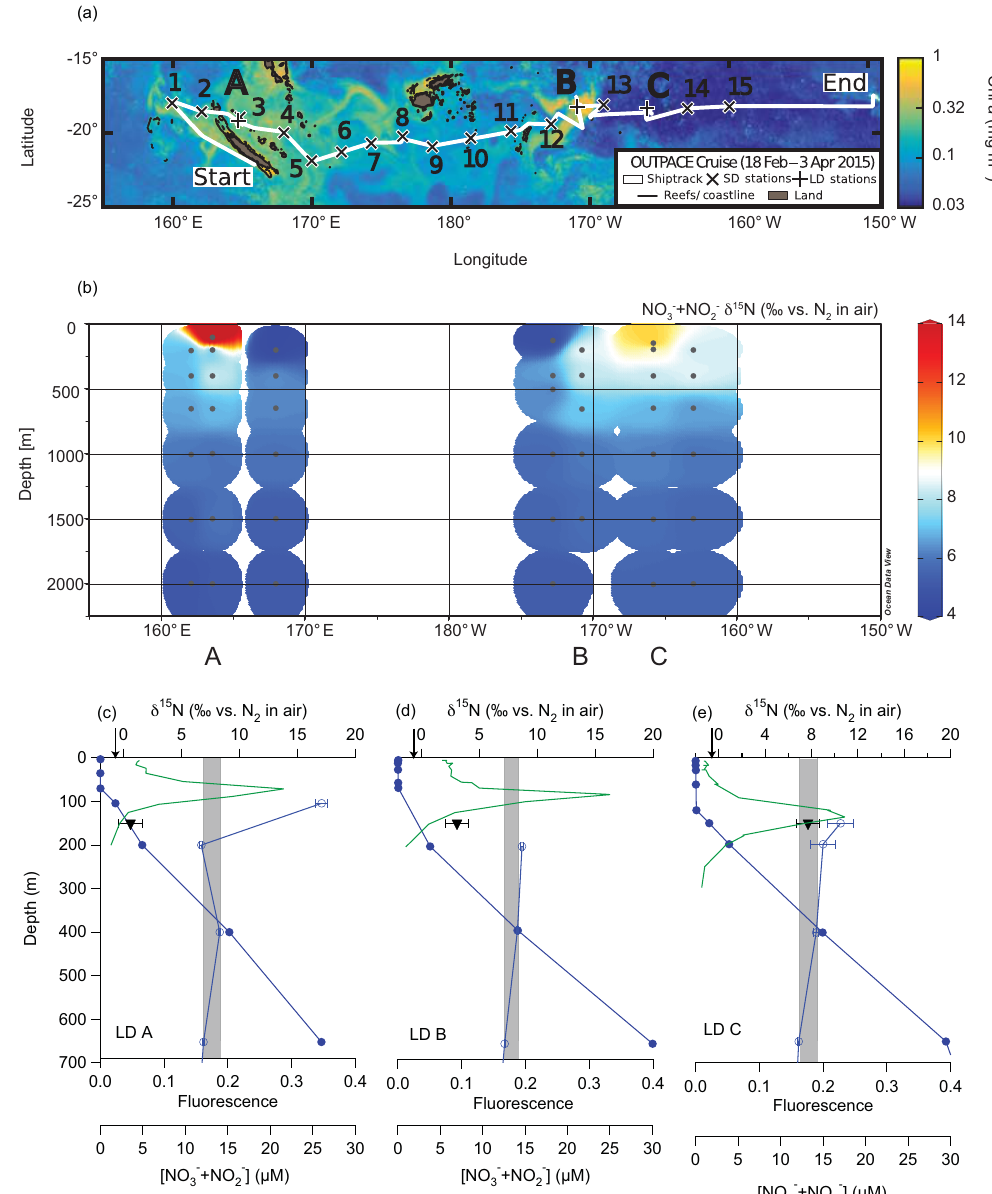
+ NO − δ 15 N mea- 3 2 + NO − + NO − δ 15 N concentration (filled circles), NO − 3 2 3 2 + NO − + NO − δ 15 N analyses. The range of concentration and most NO − 3 2 3 2